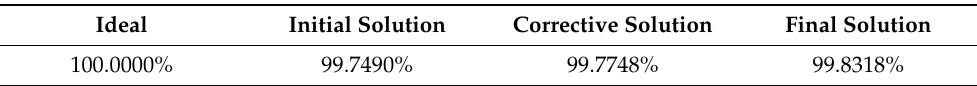
Table 23. Production time percentage for every component yielded from training the model with paired coated rollers for the bleaching machine (ZORLUTEKS).